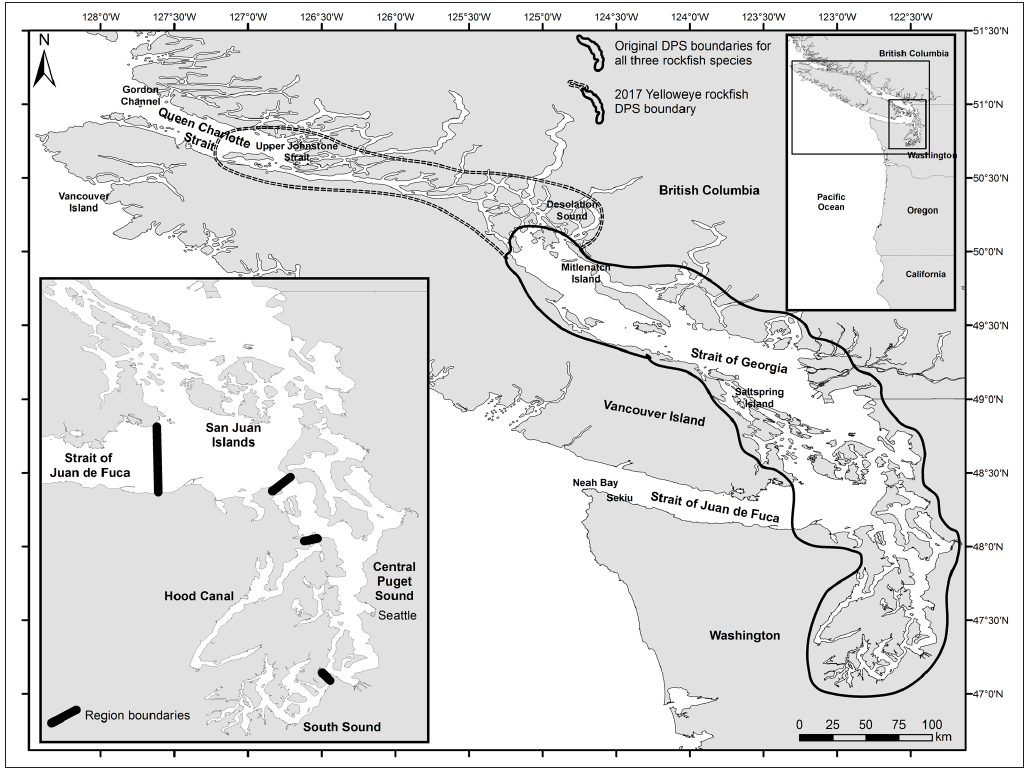
Figure 1: Map of the Puget Sound/Georgia Basin distinct population segment for each of three ESA-listed rockfish species in the original 2010 listing (solid line) and in the 2017 update for yelloweye rockfish (dashed line) and regions sampled (line breaks) with volunteer anglers for genetic